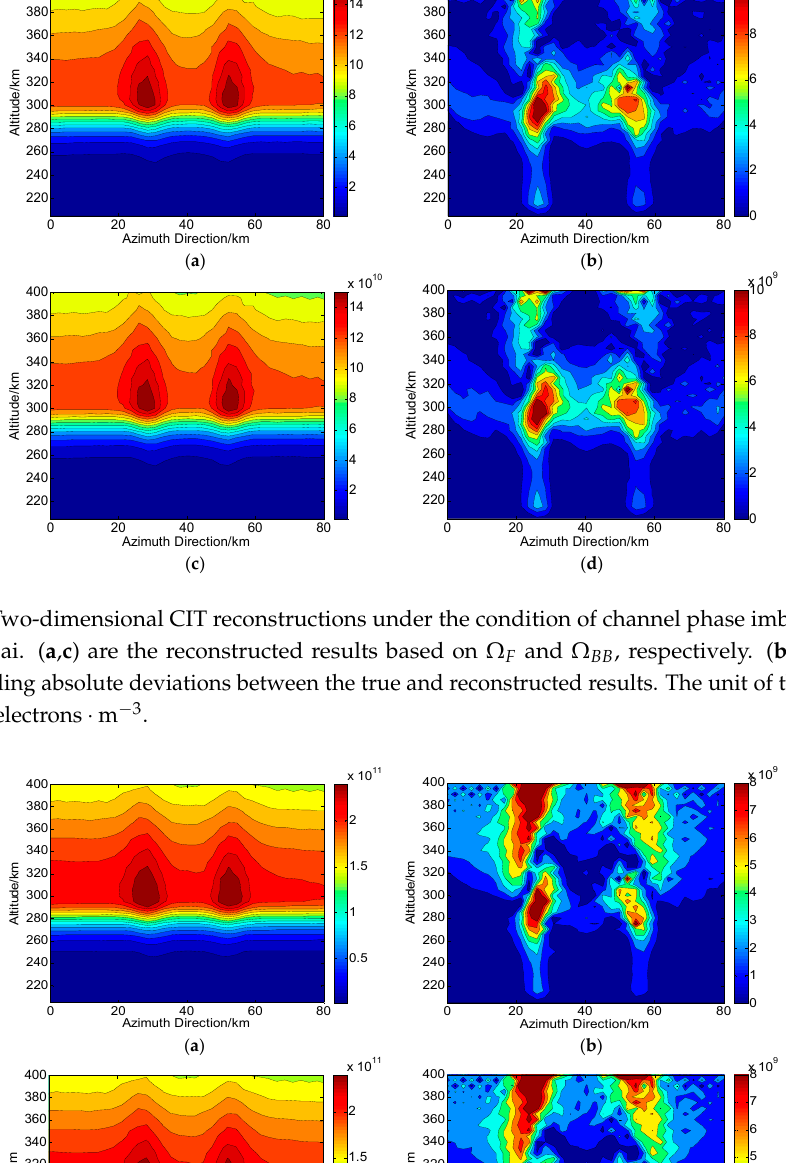
Figure 10. Two-dimensional CIT reconstructions under the condition of channel phase imbalance ( 5 °